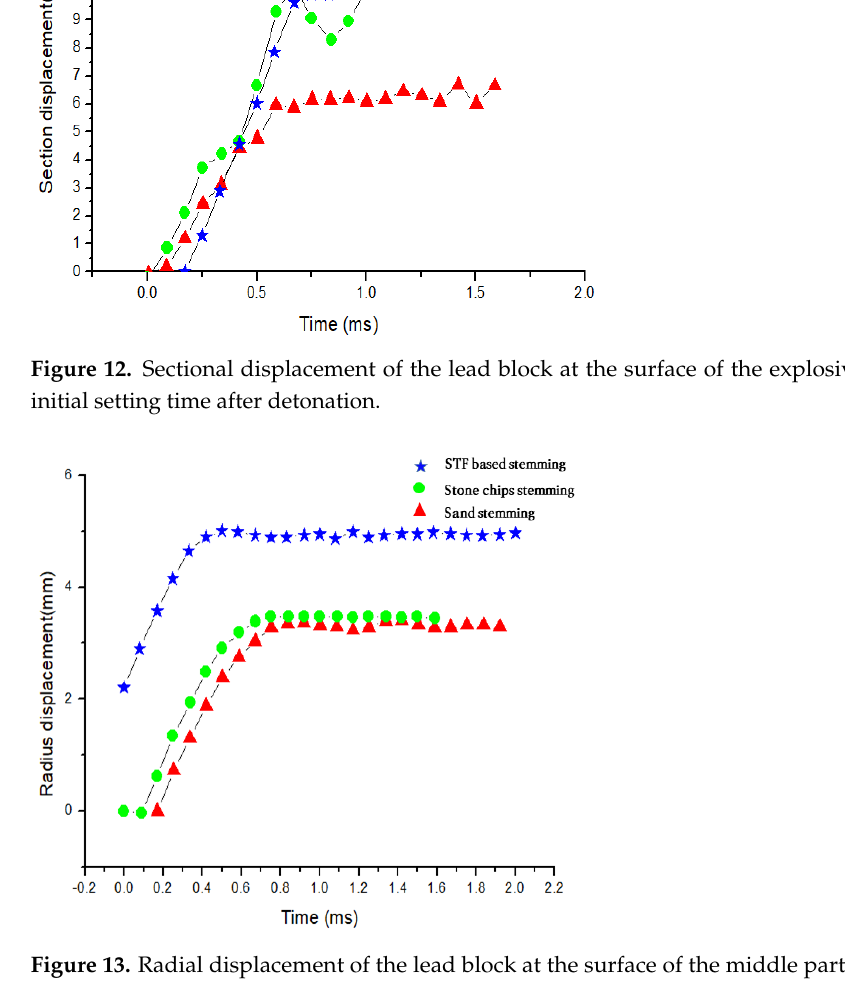
Figure 13. Radial displacement of the lead block at the surface of the middle part with initial time after detonation .